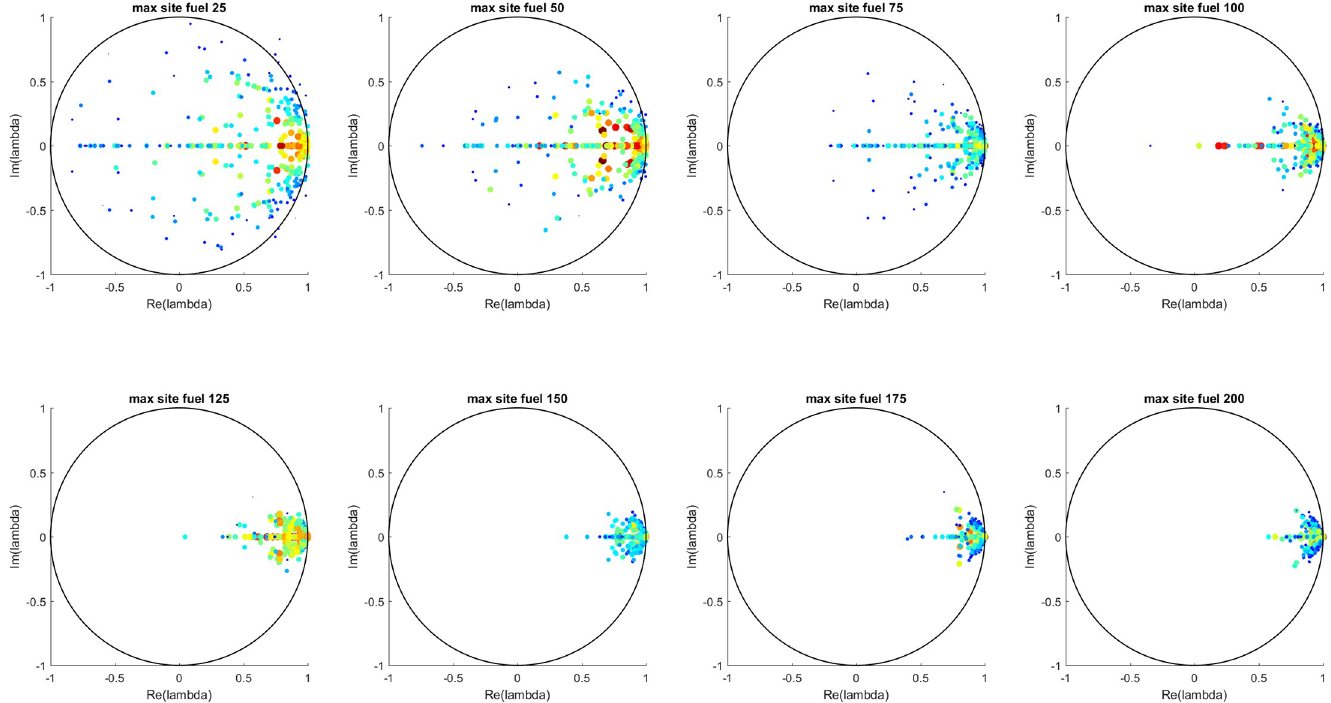
Fig 16. All eigenvalues for each maximum site fuel value. The eigenvalue color scale (blue to red) shows the L-2 norm of each eigenvalue’s associated Koopman mode. Similar to the MTF case, the eigenvalues are seem to cluster toward the real axis and unit circle with increasing maximum site fuel values.